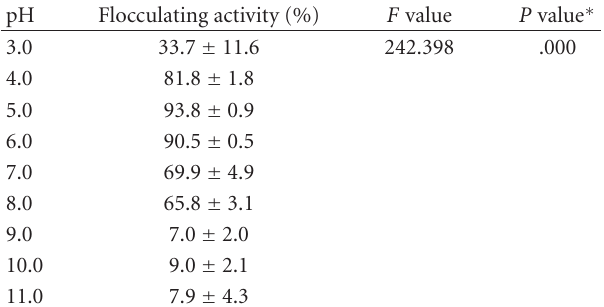
a Figure 2: The e ff ect of acidic and alkaline conditions on floccu- lating activity of bioflocculant produced by Bacillus spp . UPMB13. The pH range selected was between pH